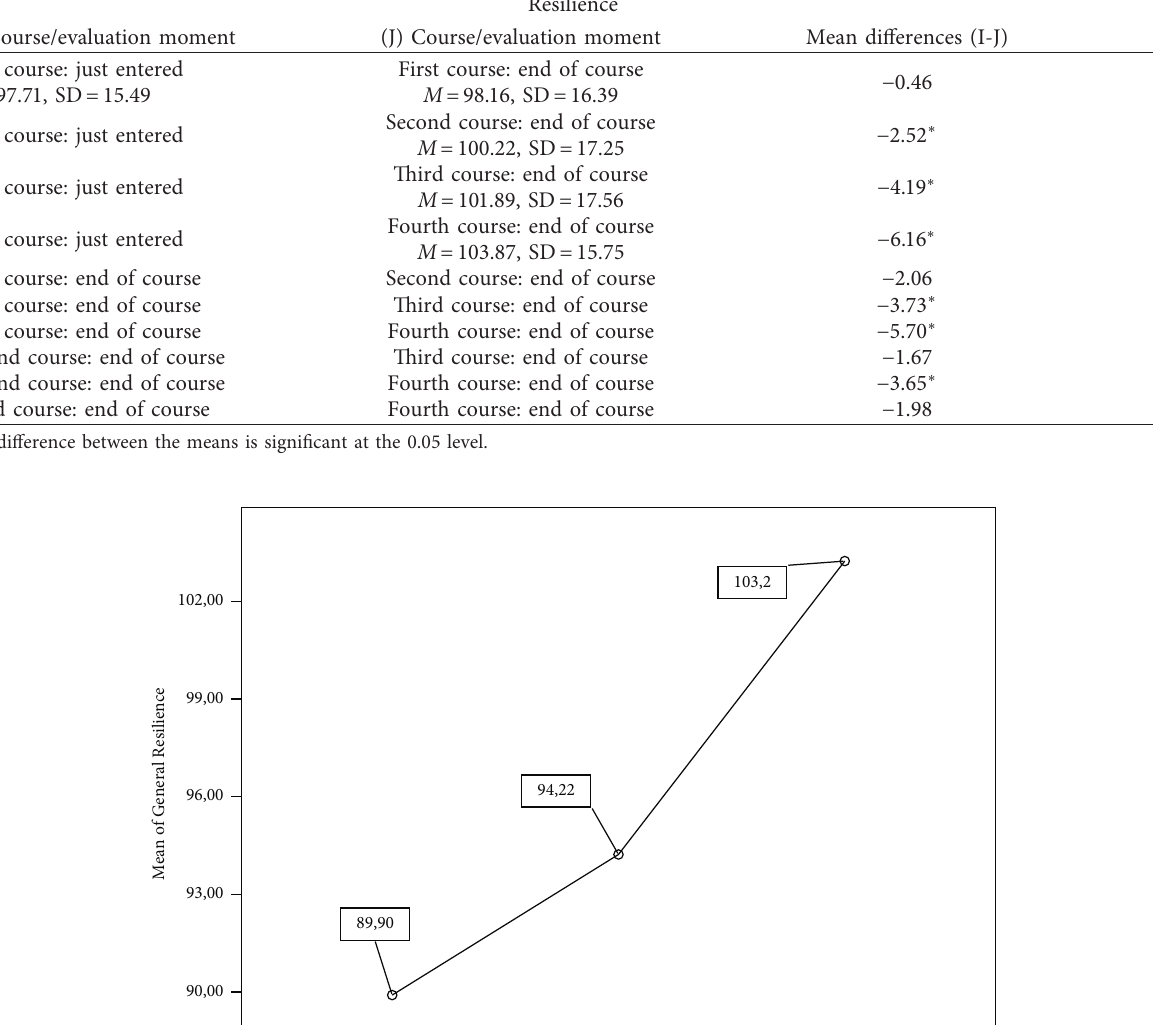
Table 4: Descriptive and post hoc tests (MSD) of differences in resilience according to the considered academic groups.